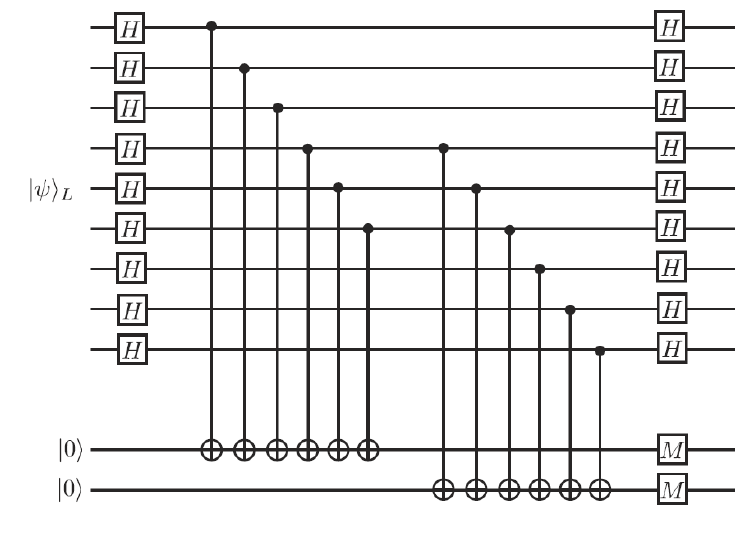
Figure 19: Circuit to detect phase-flip ( Z ) errors in the Shor 9-qubit